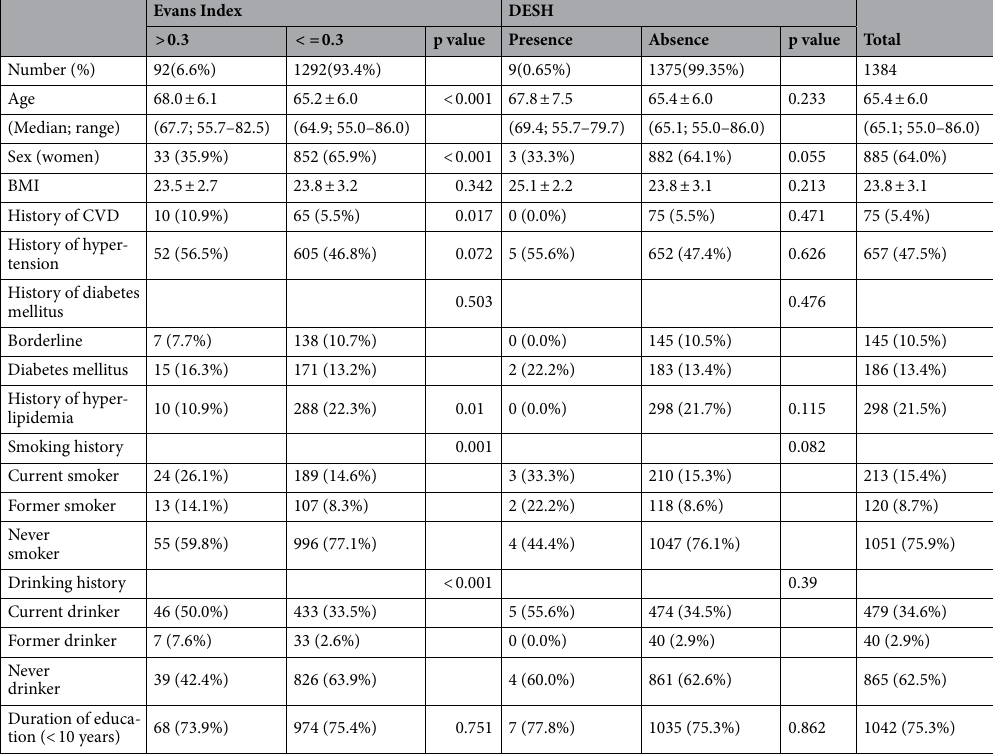
Table 1. Characteristics stratified by Evans index and DESH. Continuous data was analyzed using student’s t test and is shown in the mean ± standard deviation (median; min.-max.). Categorical data was analyzed using the χ 2 test and is shown as number (%). MMSE Mini-Mental State Examination, CVD cerevrovascular diseases, DESH disproportionately enlarged subarachnoid space